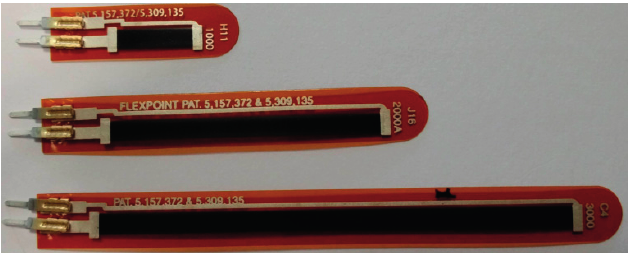
Figure 1. 2.54 cm (1”), 5.08 cm (2”), and 7.62 cm (3”) long flex sensors by Flexpoint Inc. The darker regions are covered with the carbon based resistive elements. At the left ends the metallic terminals for electric connections.